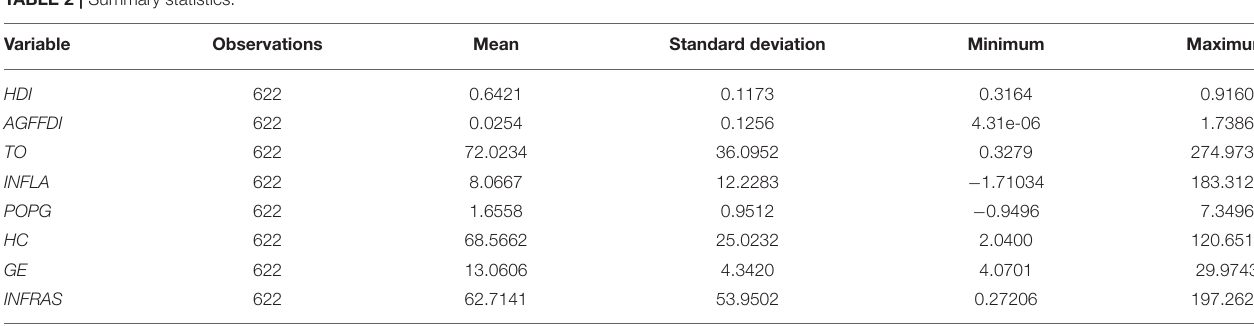
TABLE 2 | Summary